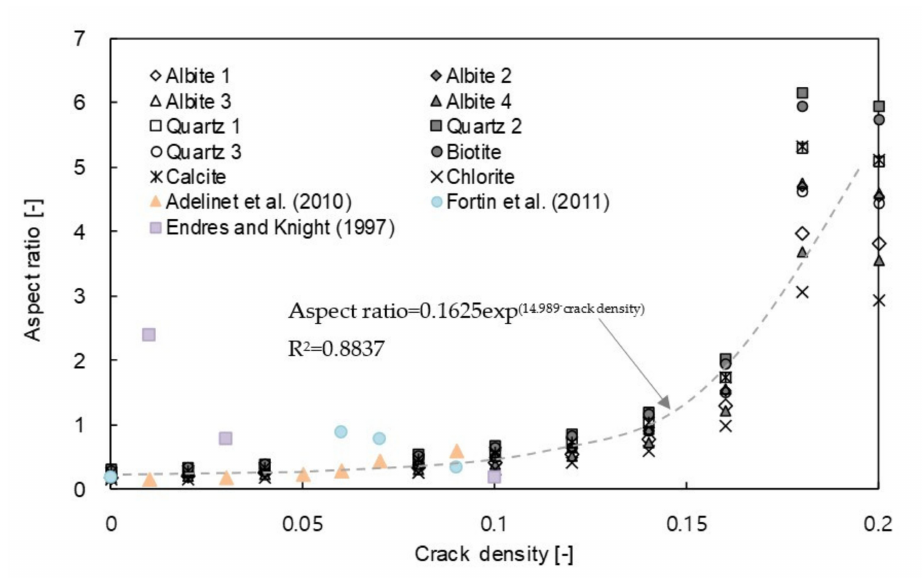
Figure 13. Relationship between aspect ratio and crack